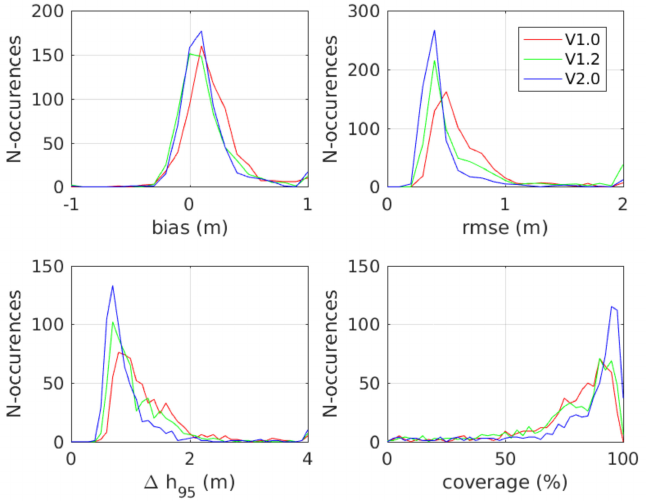
Figure 15. Histograms of the same statistics as Figure 14, but now based on common regions of sampling determined by the regions of successful estimates from the V2.0 version of